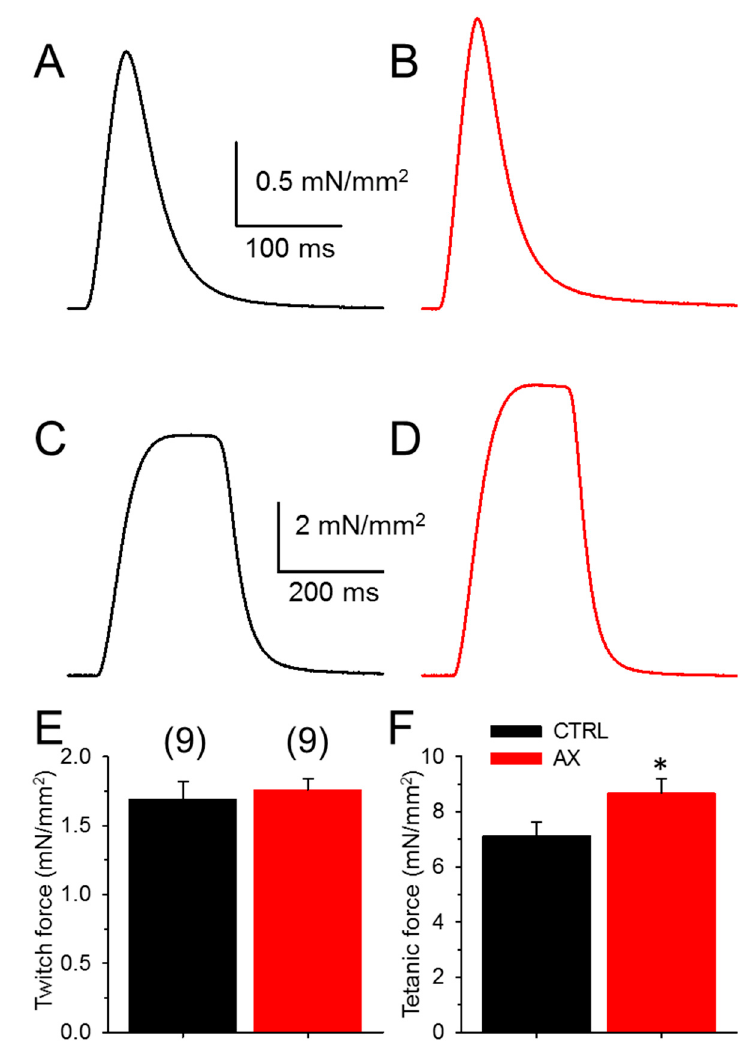
Figure 2. Increased tetanic force in EDL muscles after AX treatment. Representative ex vivo twitch ( A , B ) and tetanic ( C , D ) force on EDL muscle from CTRL (black) and AX fed (red) mice stimulated at 0.5 or 200 Hz, respectively at room temperature (22–24 °C). The force was normalized to the cross sectional area of the muscle. The numbers in parenthesis indicate the number of animals studied. The same numbers apply for both panels ( E ) and ( F ). * denotes significant difference between CTRL and AX, at p < 0.05. Table 1. Force parameters from 9 control and 9 AX treated mice.